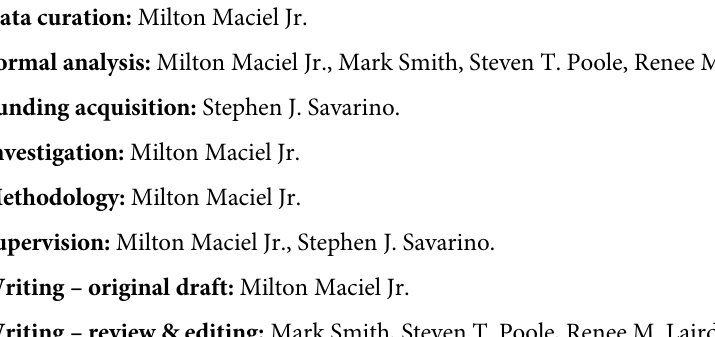
S4 Fig. Raw images—Dose